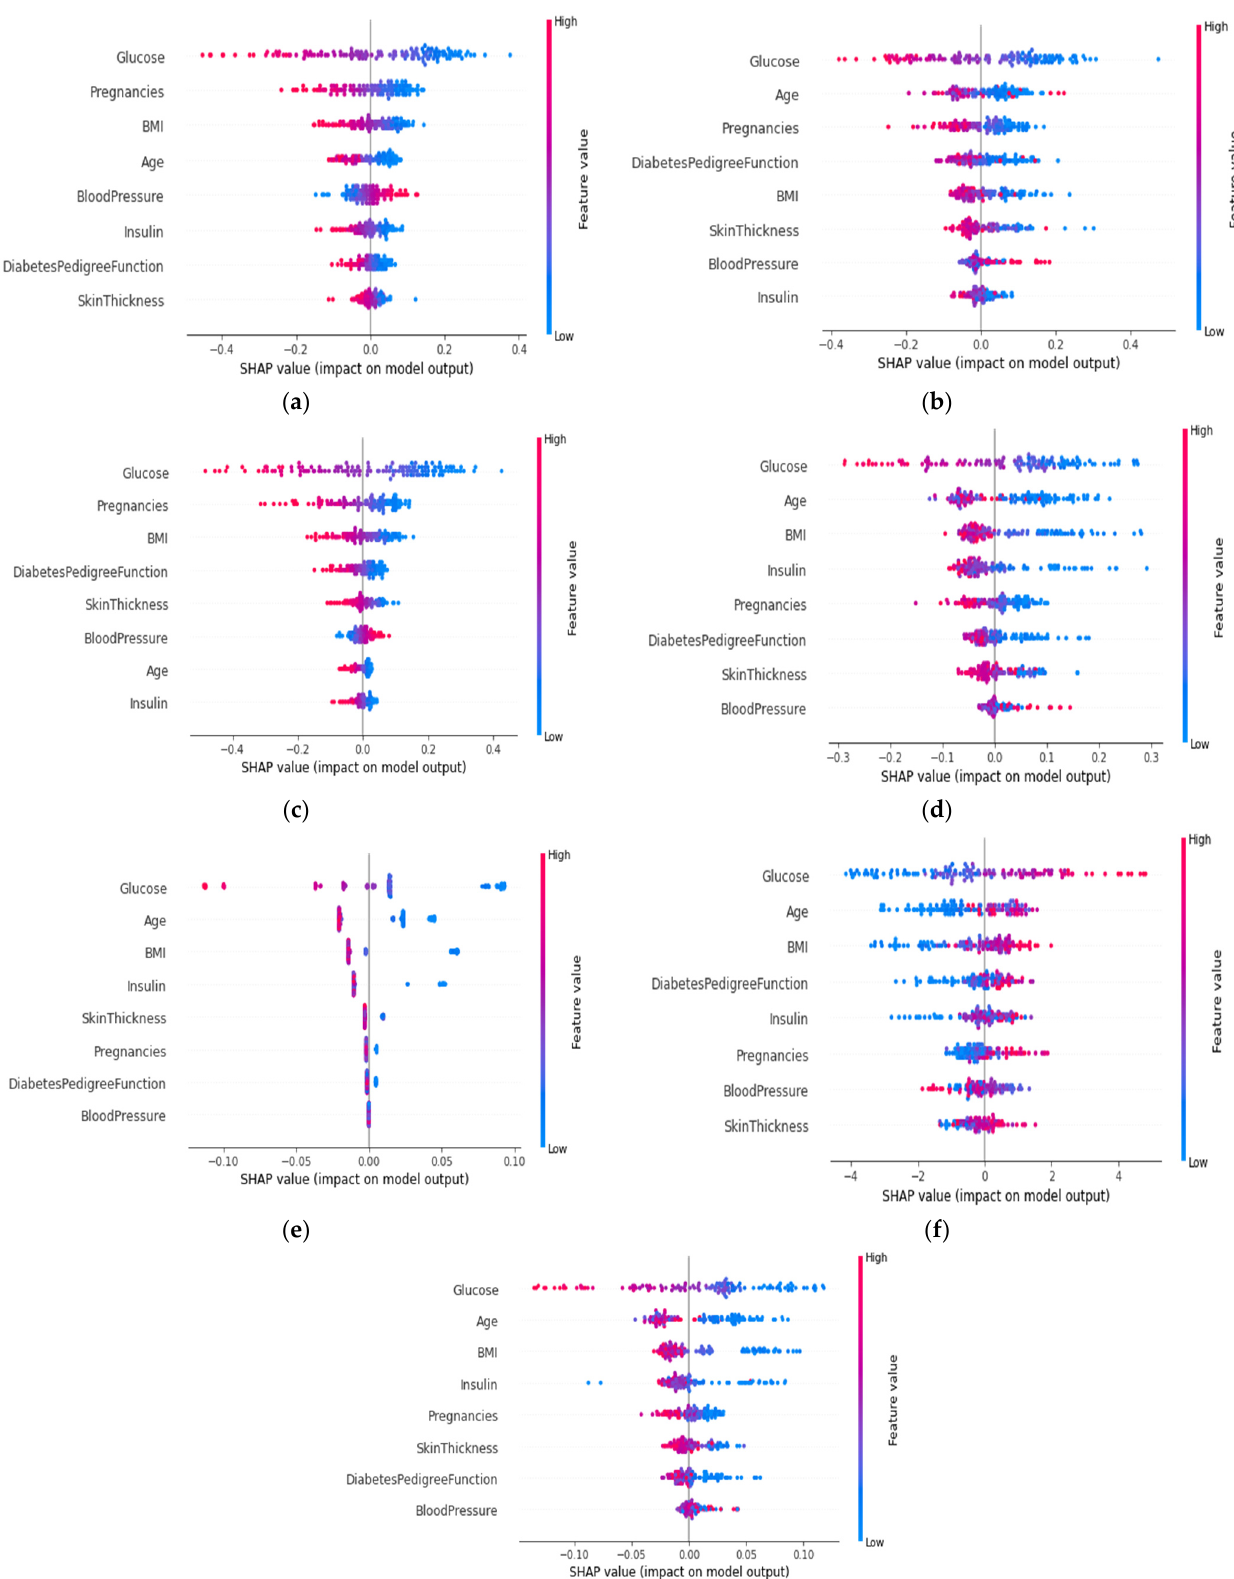
Figure 12. Summary plot of ( a ) ANN, ( b ) SVM, ( c ) LR, ( d ) RF, ( e ) ADA, ( f ) XGB, and ( g ) Voting classifier.